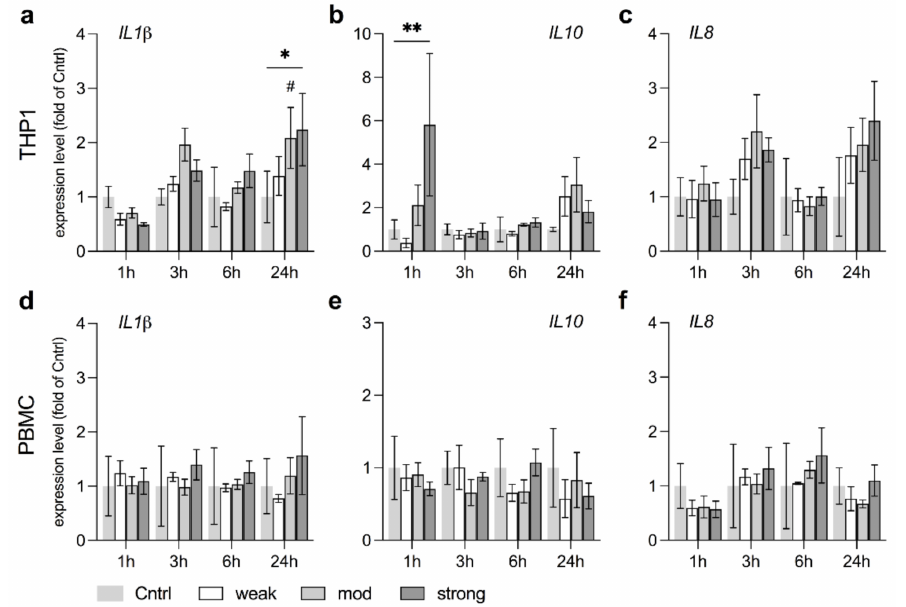
Figure 7. stEMF exposure increases expression of inflammatory cytokines in THP1 ( a – c ) but not PBMC ( d – f ). Expression levels of the major pro- and anti-inflammatory cytokines IL1B ( a , d ) and IL10 ( b , e ), as well as the chemokine IL8 ( c , f ), were tested after exposure to wkEMF, mdEMF or stEMF to investigate potential immune stimulating effects of EMF in a dose-dependent approach. Data are given as fold of Cntrl (mean ± SEM, N = 3, n = 2). * p < 0.05 and ** p < 0.01 as indicated. p < 0.08 (#) indicates a